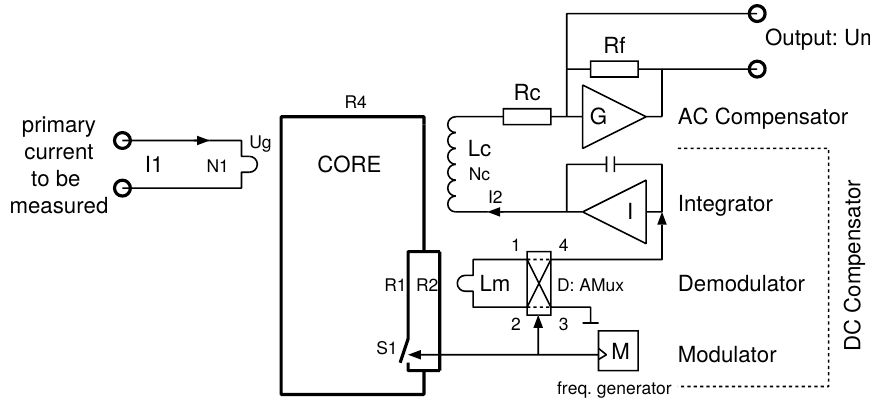
Figure 7. Block diagram of the DC-CT with the Platiše Flux